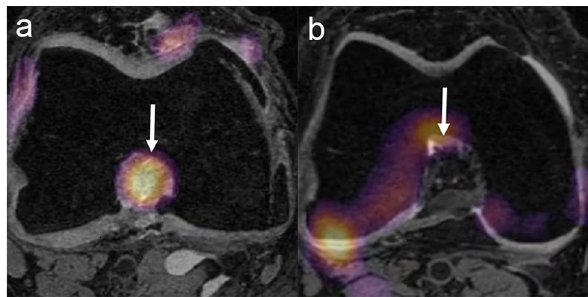
Figure 4. ( a ) Baseline axial DESS reformatted image of a case subject (WOMAC pain score—4, stiffness score—32, disability score—1) with TKR shows a region of discriminative high activation within the intercondylar notch (arrow). ( b ) Baseline axial DESS reformatted image of a control subject (WOMAC pain score—0, stiffness score—0, disability score—0) without TKR does not show a region of discriminative high activation within the intercondylar notch